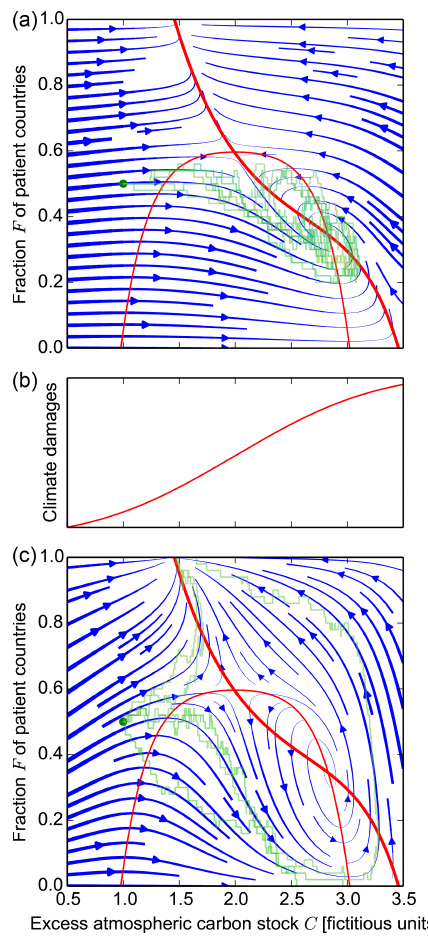
Figure 4. Typical dynamics of the copan:DISCOUNT model of the co-evolution of the global atmospheric carbon stock C and the time preferences of countries, represented by the fraction F of pa- tient countries. Of five simulated stochastic trajectories ( a and c , green lines) starting at the same initial state (green dot), some will converge fast to the more desirable stable steady state at C ≈ 1 . 5, F = 1, where climate damages (b) are still relatively low, while other trajectories will approach the less desirable focus point (spi- ralling steady state) at C ≈ 2 . 8, F = 0 . 35, where climate damages are relatively high. Depending on whether countries adjust their time preferences slowly (a) or fast (c) , the focus point is either a sta- ble attractor catching most trajectories that come near it (a) or an un- stable repeller which many trajectories have to compass to approach the desirable state after a long transient detour of high damages (c) . Blue lines show the average development represented by two ordi- nary differential equations (see Appendix A for details), red lines are the corresponding nullclines (thin: ˙ F = 0; thick: ˙ C = 0), and their other intersection at C ≈ 2, F ≈ 0 . 6 is a saddle point. The pa- rameters used are as follows: E 0 = 1 . 6, c = 1, r = 0 . 45, l = 0 . 2 (a) or 1 . 3 (c) , γ = 1 . 1, µ = 2, σ = 1, β = 0 . 1, α = 0 . 5, G = 2, N = 50, p 0 = 0 . 5 and q =